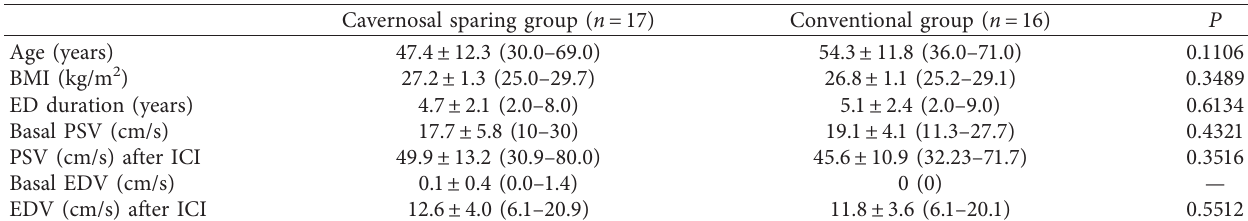
Figure 3: Postoperative post-PDE5i hemodynamics. Postoperative post-PDE5i hemodynamics measurements showing pronounced cavernosal artery waves, recorded 20 minutes after PDE5i administration and manual stimulation. Please note that Figures 2 and 3 are for the same patient. Table 1: Patients’ characteristics and preoperative baseline measurements (mean ± SD, range).